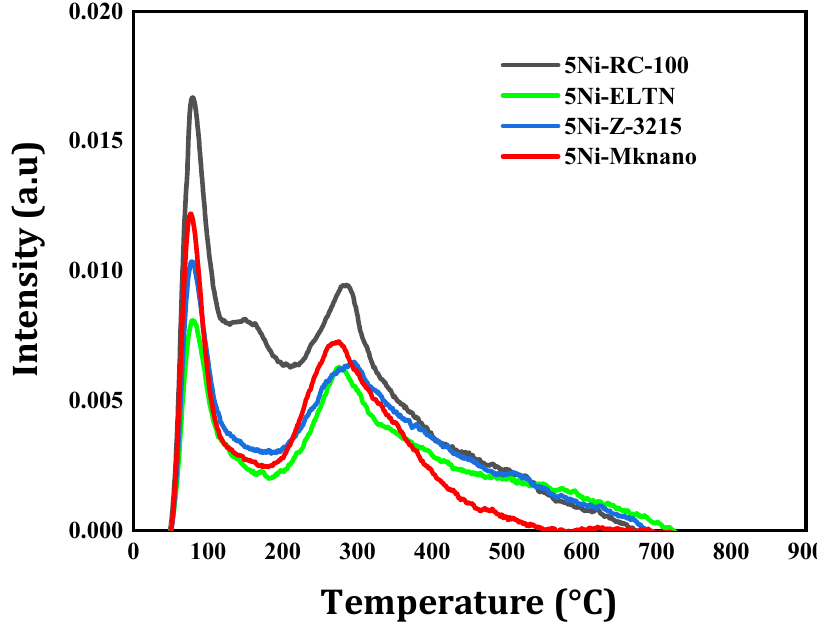
Figure 3. CO Figure 3. CO 2 - TPD profiles of different ZrO 2 sources supported Ni samples. 2 − TPD profiles of different ZrO 2 sources supported Ni